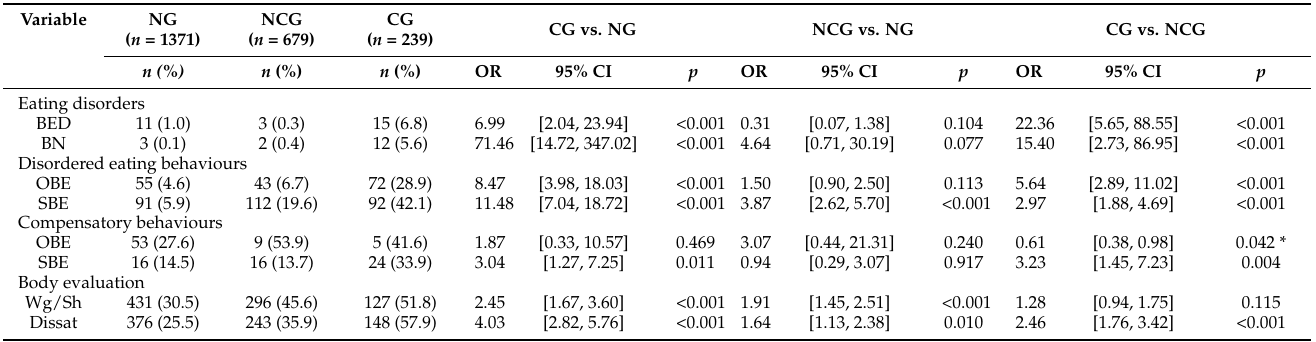
Table 2. Prevalence and odds of eating disorders and eating disorder symptomatology according to grazing